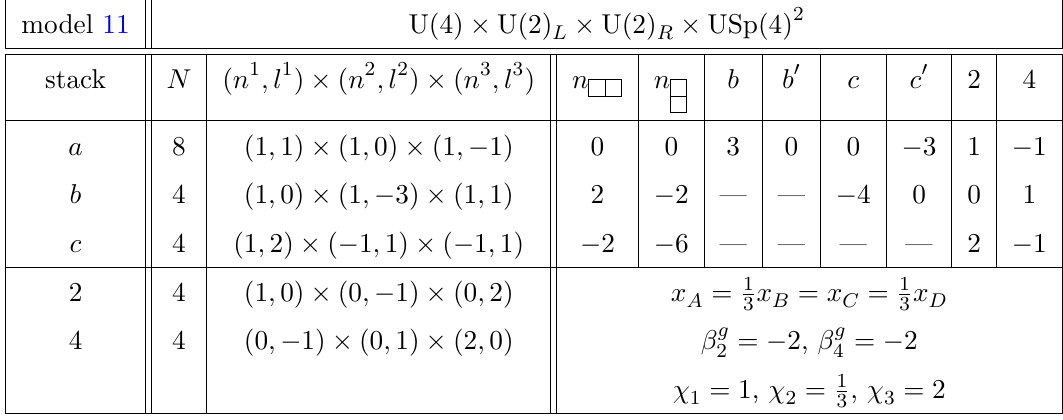
Table 11 . D6-brane configurations and intersection numbers of Model 11, and its MSSM